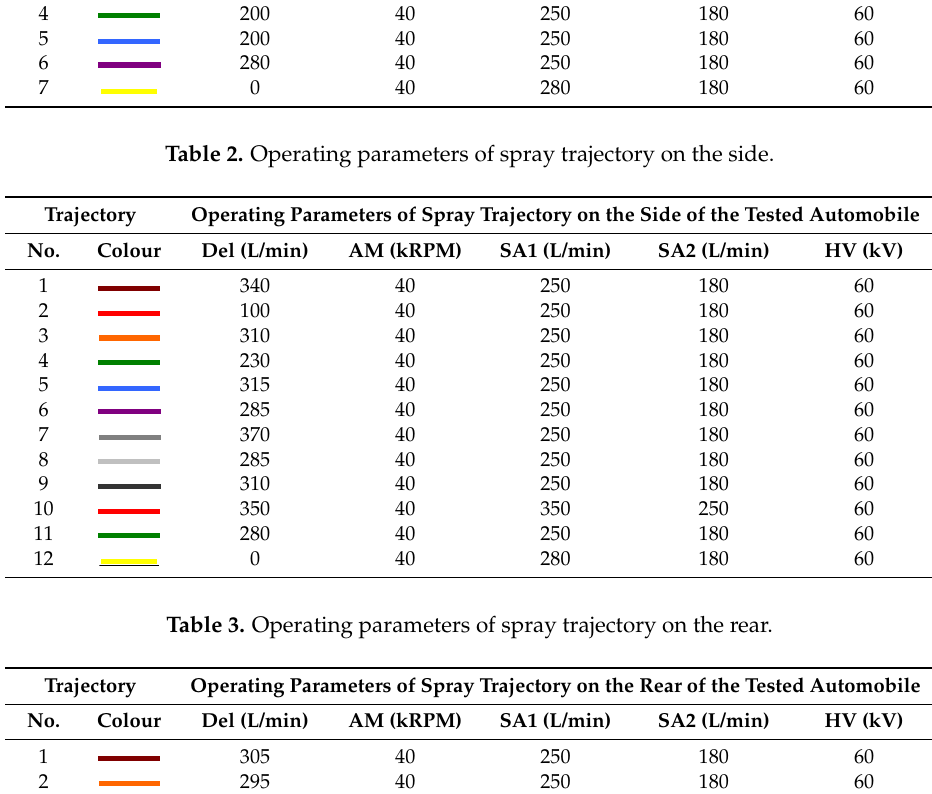
Table 3. Operating parameters of spray trajectory on the rear.